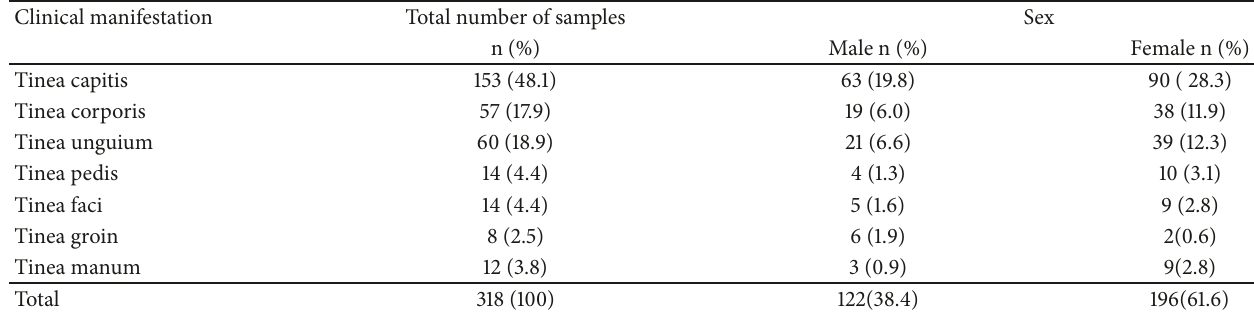
Table 1: Frequency of clinical manifestation in relation to